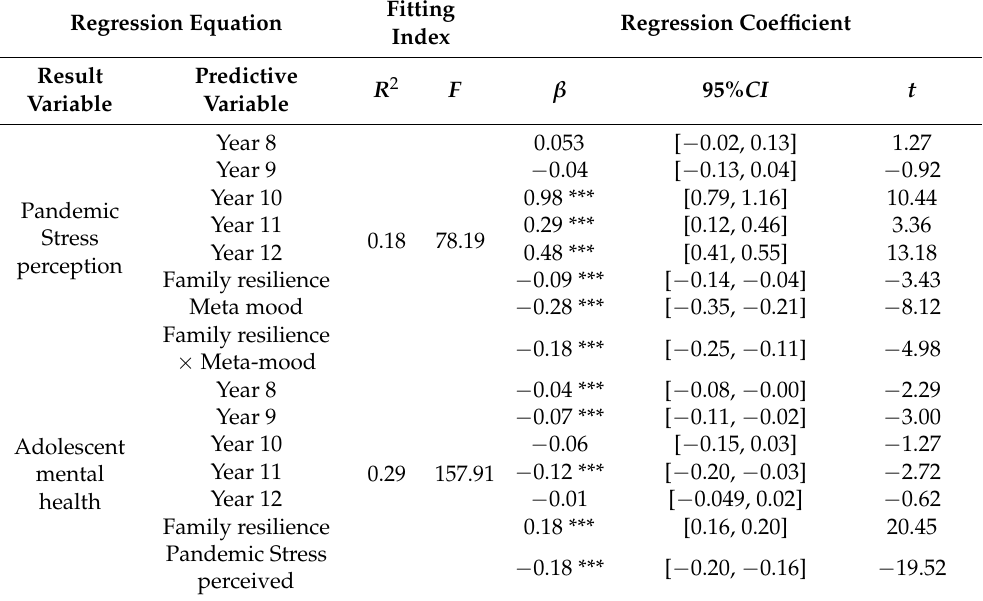
Table 10. The moderated mediation effect